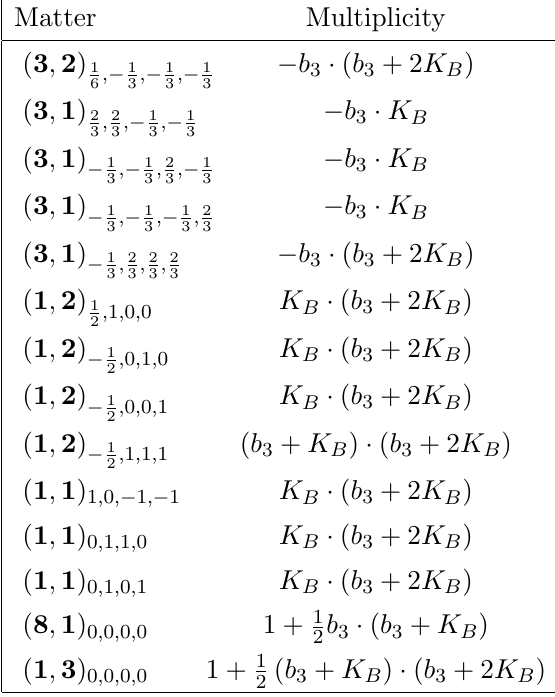
Table 7 . Matter spectrum for the model when [ d 2 ] is ine(cid:11)ective and [ s 1 ], [ s 5 ], and [ s 8 ] are trivial, with multiplicities for a 6D model.